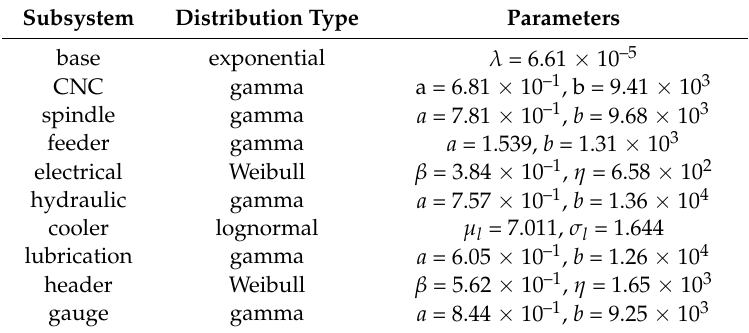
Table 2. Reliability models and parameters of subsystems. CNC—computer numerical control; MTBF—mean time between